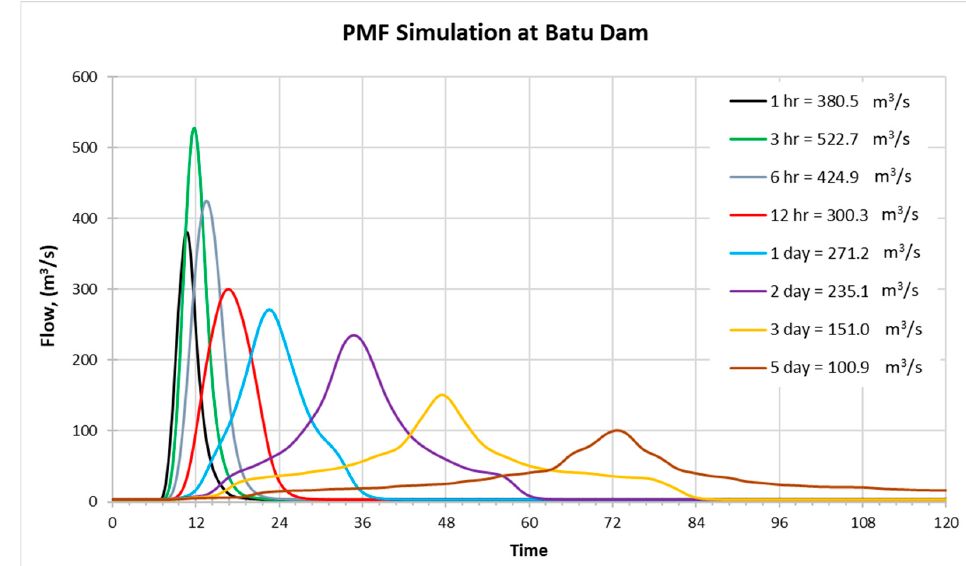
Figure 11. PMF simulations at Batu dam.